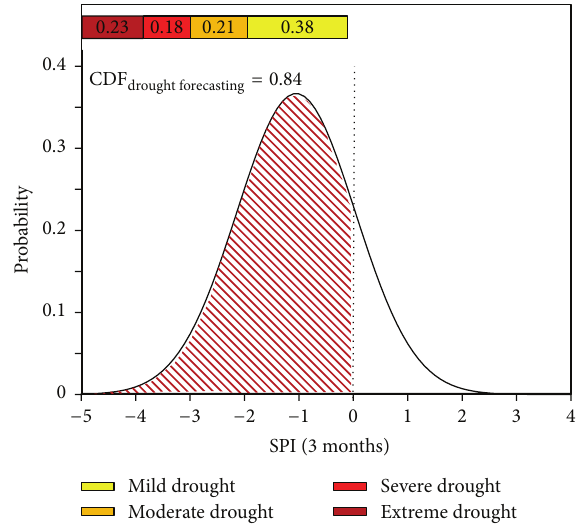
Figure 7: Drought forecasting probability from the BNDF model (Wonju station, March